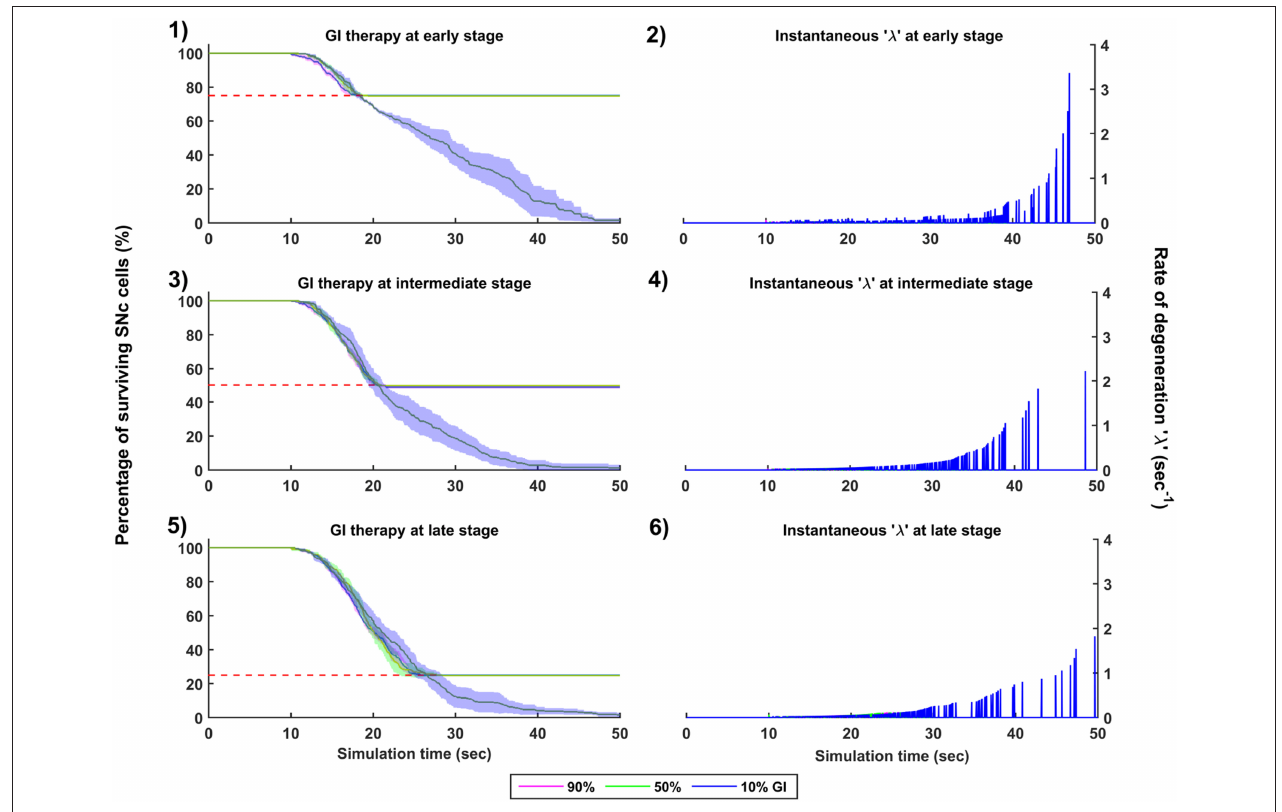
FIGURE 8 | Simulation plots for Glutamate Inhibition (GI) therapy. Progression of SNc cell loss for 90, 50, and 10% GI at early (25%) (1) , intermediate (50%) (3) and late (75%) (5) stages of SNc cell loss. Instantaneous rate of degeneration ( λ ) for 90, 50, and 10% GI at early (25%) (2) , intermediate (50%) (4) and late (75%) (6) stages of SNc cell loss. SNc, Substantia Nigra pars